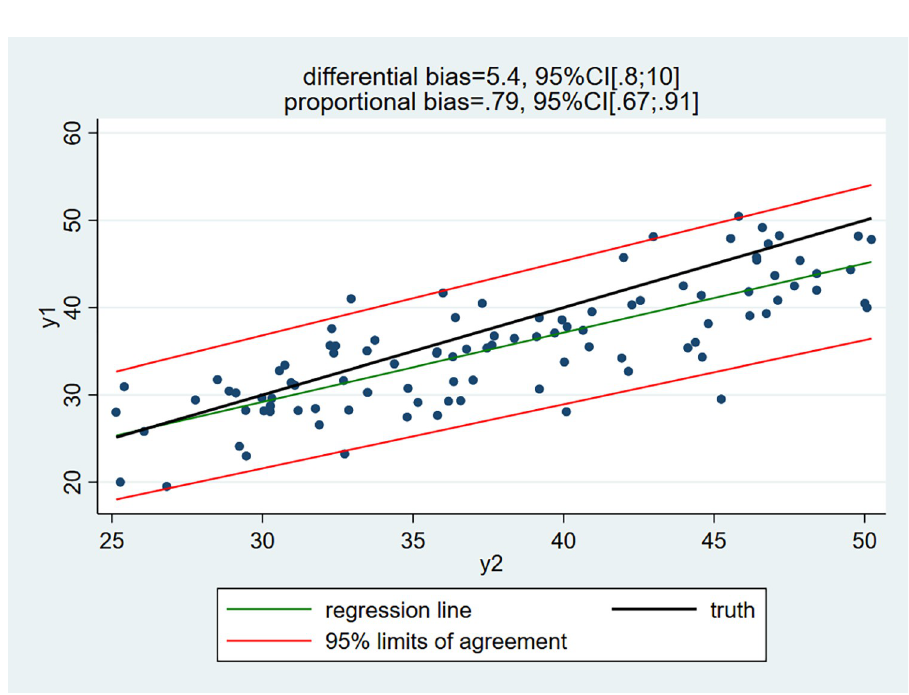
Fig 3. Simulated data: Linear regression of y1 on y2 with 95% limits of agreement.